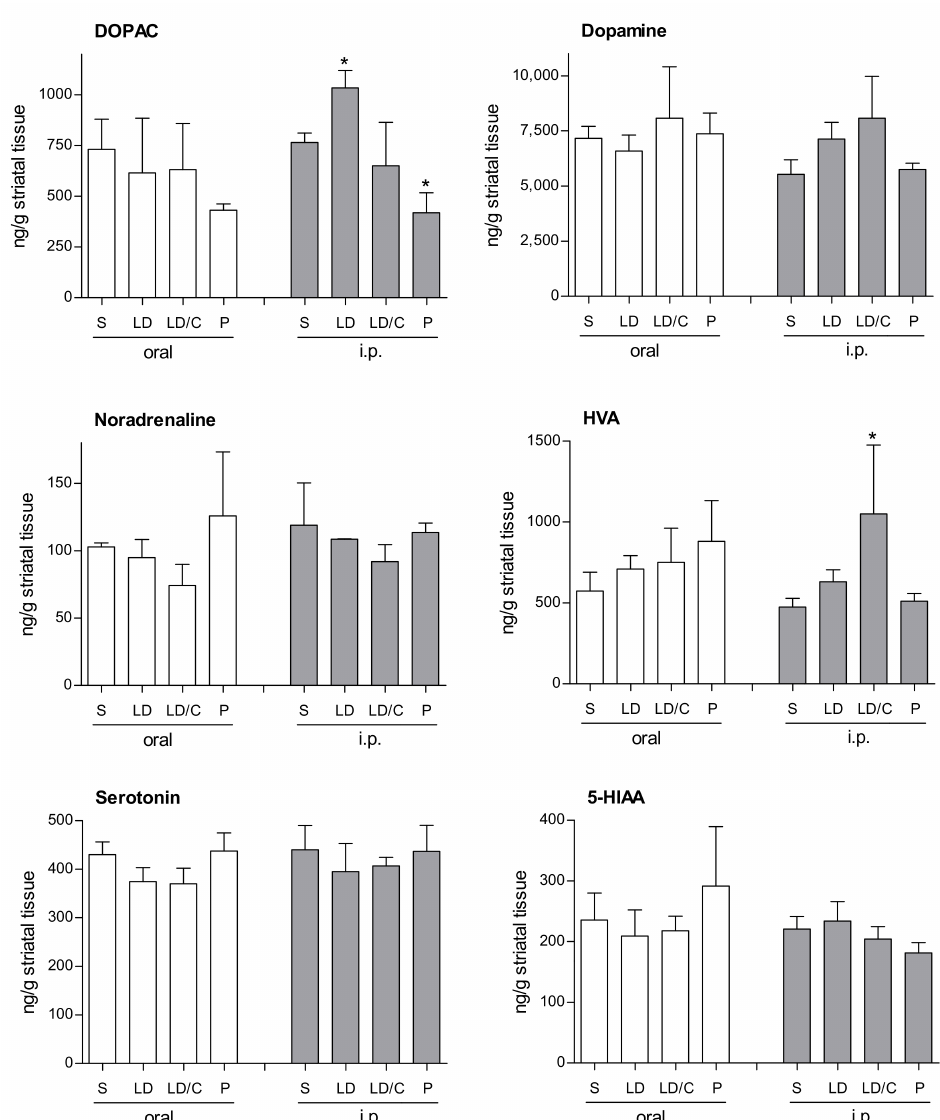
Figure 7. The concentrations of selected monoamines and metabolites in the striatum of mice following oral and intraperitoneal (ip) treatment with saline (S), L -dopa (LD), L -dopa and carbidopa (LD/C), or the L -dopa–lazabemide prodrug (P). Values are given as mean ± standard deviation with statistical comparisons to the saline-treated animals indicated (* p < 0.05; n =